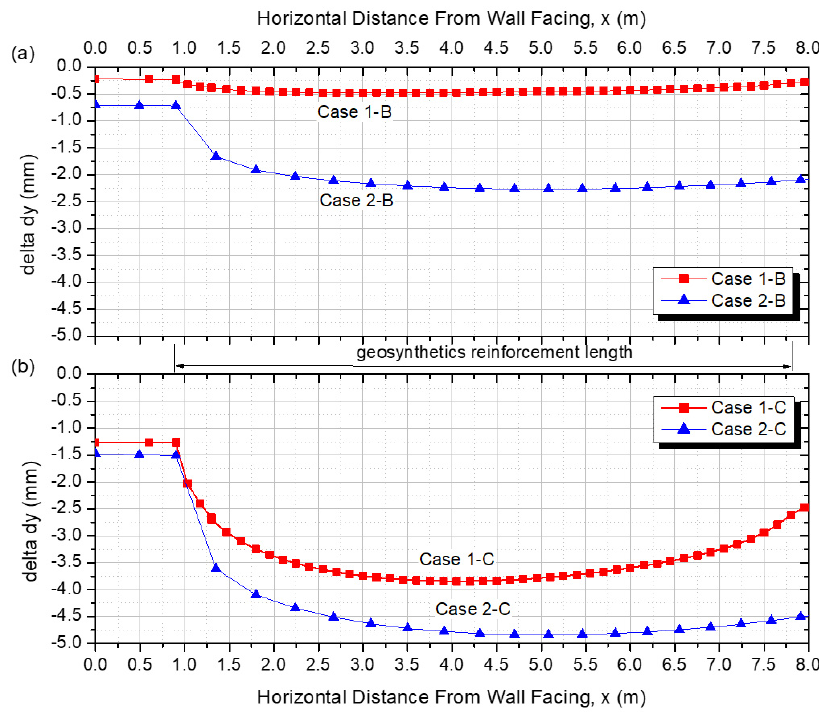
Figure 4. Vertical Displacement Increments at the top of Wall Abutment, ∆ dy (mm), due to ( a ) Gen- eral Traffic Loading (Case 1B-2B) and ( b ) Railway Loading (Case 1C-2C). Traffic Loading (Case 1B-2B) and ( b ) Railway Loading (Case